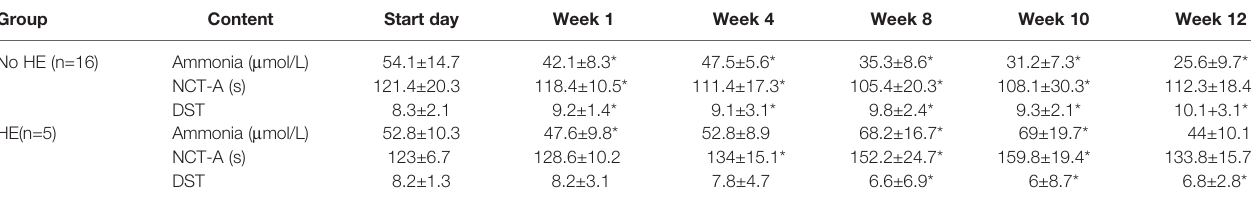
TABLE 1 | Results of ammonia measurement and cognitive test scores in patients during rifaximin- a administration.